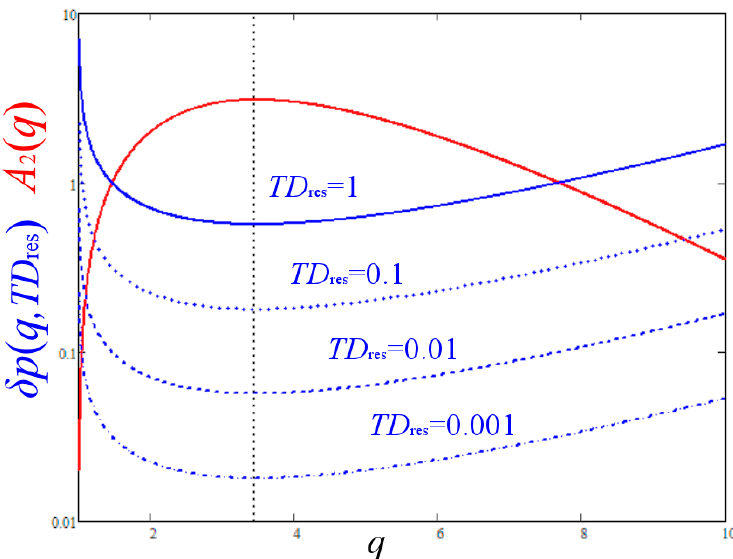
Figure 3. The curvature A 2 , which measures the sensitivity of fitting, is plotted as a function of the norm q . Its largest value A 2 ≈ 3.09 corresponds to the maximum sensitivity q ≈ 3.47. The corresponding error of the optimal parameter value is minimized for the same norm that maximizes the sensitivity, and is plotted for TD res = 0.001 (dash-dot), 0.01 (dash), 0.1 (dot), and 1 (solid blue line).